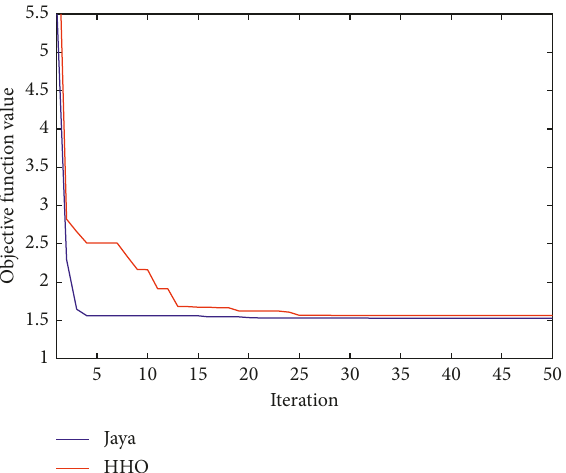
Figure 4: Convergence characteristics for the 3-bus system by NLP formulation.